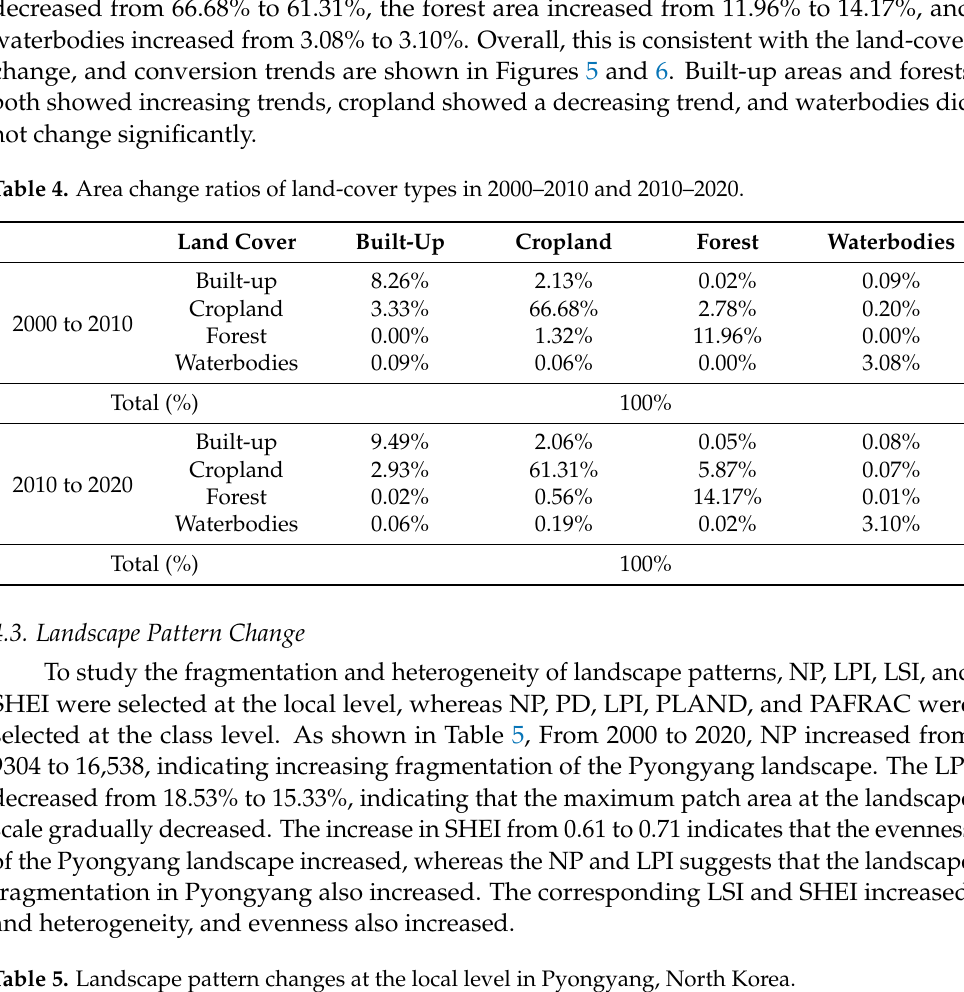
Table 5. Landscape pattern changes at the local level in Pyongyang, North Korea. Local Level Landscape